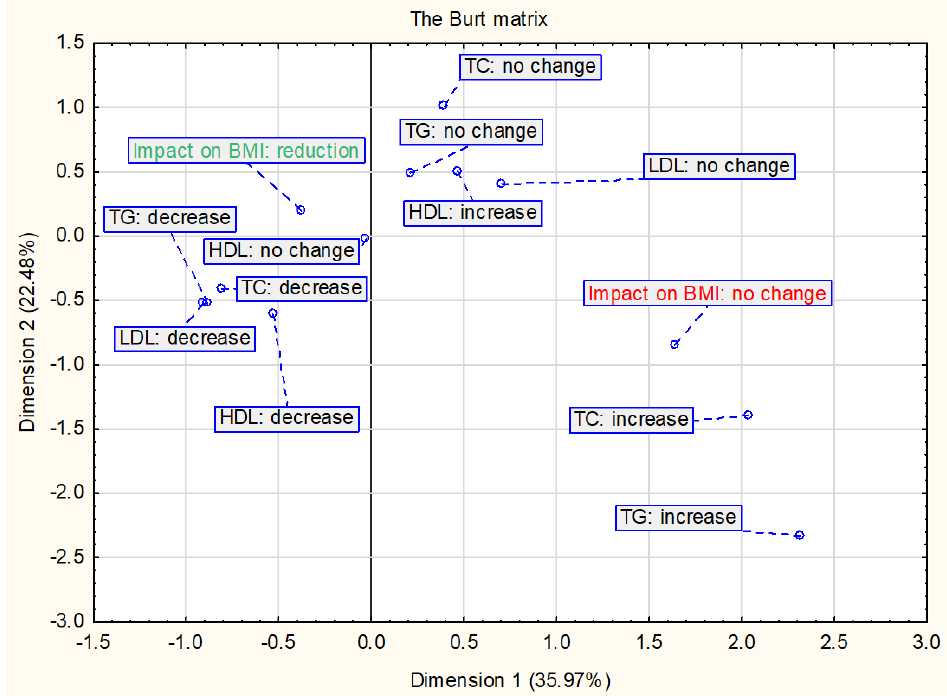
Figure 3. Presentation of the correspondence analysis results defining the relationship between the changes in BMI and/or BMI z-score and changes in lipid parameters ( n = 16).